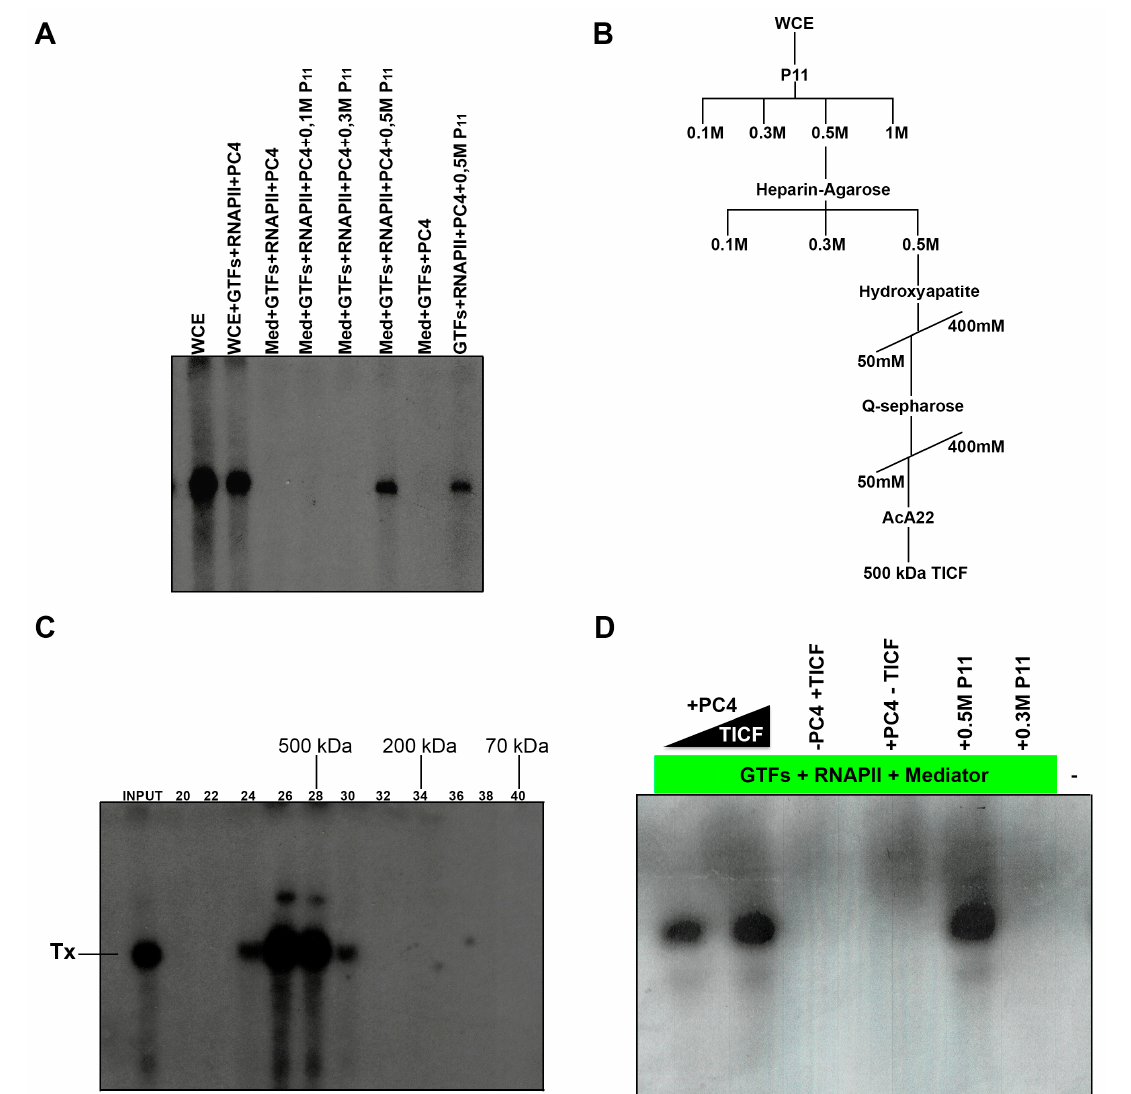
Figure 6. Nmt1 Inr transcription can be reconstituted with GTFs, RNAPII, Mediator, PC4, and a crude fraction from the 0.5 M P11 chromatographic column. A transcription assay for the nmt1 Inr was set up with GTFs, RNAPII, Mediator, and PC4; however, this purified system was not able to transcribe the nmt1 promoter. Addition of a crude chromatographic fraction from a P11 column (0.5 M P11) can support transcription in this assay. Addition of other chromatographic fractions from the P11 column (0.1 M and 0.3 M P11) do not support transcription from this promoter. ( A ) Omission of Mediator from the assay slightly diminishes transcription. ( B ) Chromatographic scheme of purification of TICF through several steps. The activity was followed by transcription assays set up with the nmt1 Inr template, GTFs, RNAPII, Mediator, and PC4. ( C ) Transcription assay and estimation of the molecular weight of TICF by gel filtration (AcA22 column). The molecular weight of TICF is near 500 kDa, as determined in the gel filtration column. ( D ) The activity of TICF is dependent on PC4. A transcription assay set up with GTFs, Mediator, and RNAPII can transcribe the nmt1 Inr when TICF and PC4 are added; however, when PC4 is absent from the assay (-PC4 + TICF), transcription no longer occurs. Consequently, when TCIF is omitted (+PC4-TCIF), transcription does not occur. The crude chromatographic fraction of 0.5 M P11 can replace TICF and PC4 (+0.5 M P11), however, the 0.3 M P11 fraction cannot replace the activities (+0.5 M P11). Tx indicates the transcription